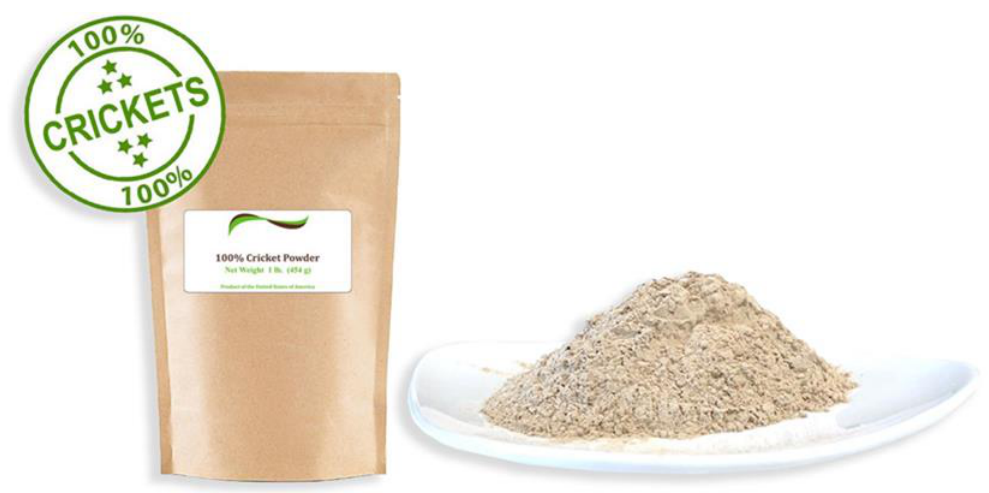
Figure 2. Edible cricket protein (ECP) picture presented in the ECP+ informed condition † . † Treatments are described in Figure 1.